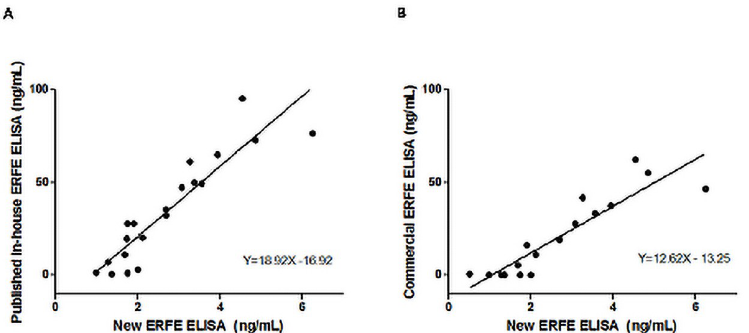
Fig 1. Comparison of our new ERFE ELISA with a published in-house assay (A) and commercial kit (B) using linear regression analysis. (A), n = 23 serum samples or (B) n = 20 serum samples. Statistical analysis was performed using linear regression analysis. (A: R 2 = 0.8332, p < 0.001; B: R 2 = 0.8258, p < 0.0001).